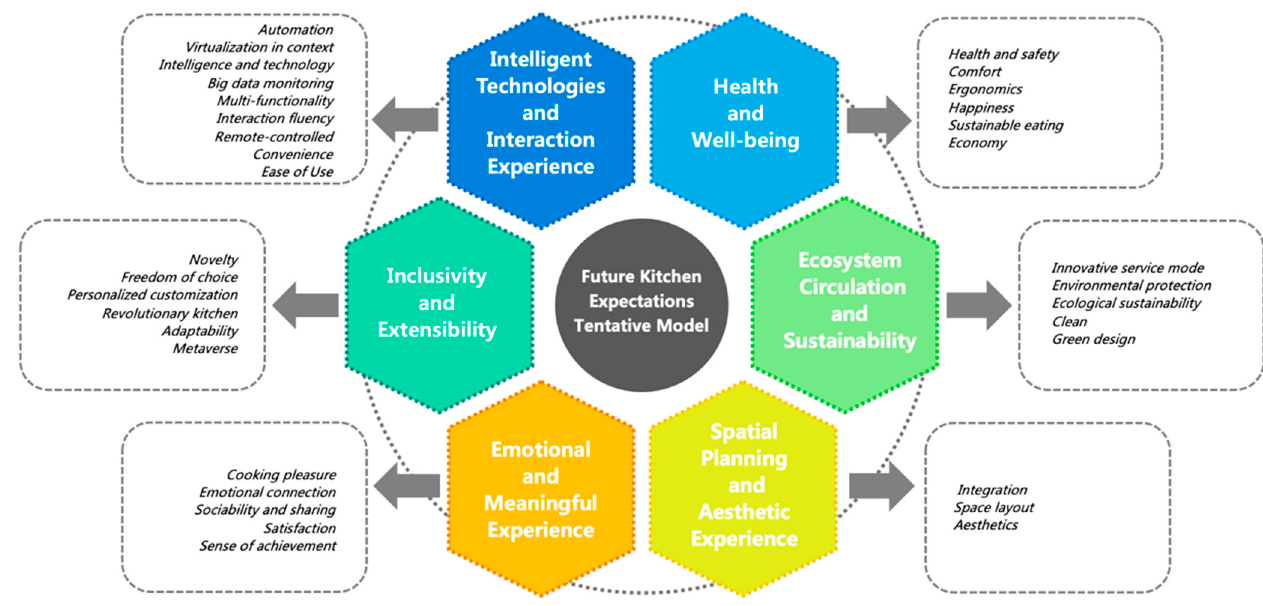
Figure 3. A tentative model of future kitchen expectations for Chinese college students.